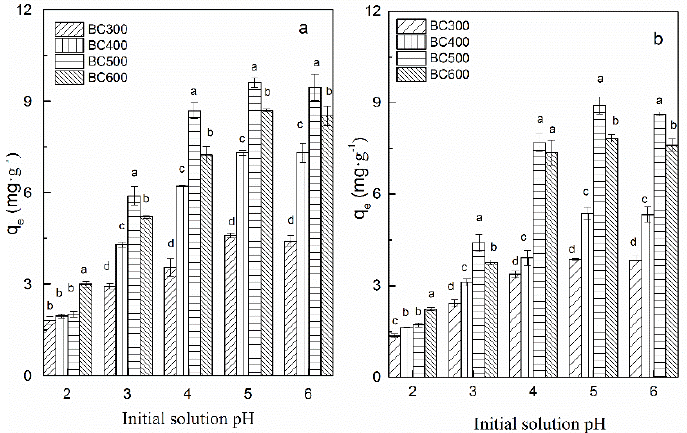
Figure 2. E ff ect of initial solution pH on Cu(II) ( a ) and Zn(II) ( b ) adsorption by BCs produced at di ff erent temperatures (initial Cu(II) concentration 64 mg L − 1 , initial Zn(II) concentration 65 mg L − 1 ; reaction temperature 25 ◦ C; BC dosage 5 g · L − 1 ; contact time 1440 min). Error bars represent standard error ( n = 3). Di ff erent letters above bars within the same pH condition indicate significant di ff erences among BCs ( p < 0.05).